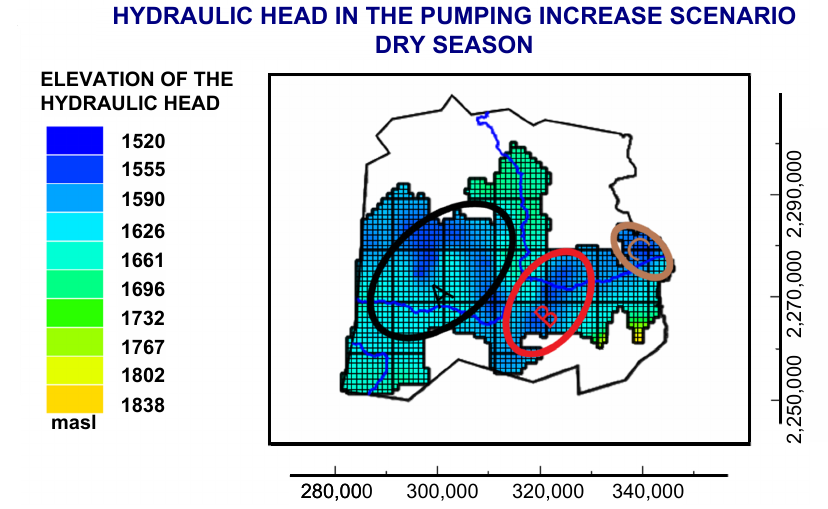
Figure 19. Elevation of the hydraulic head of the year 2030 through the pumping increase scenario in Figura 3.6: Elevaci´on de la carga hidr´aulica del a˜no 2030 a trav´es del escenario Aumento de Bombeo the dry en la Temporada de Secas.